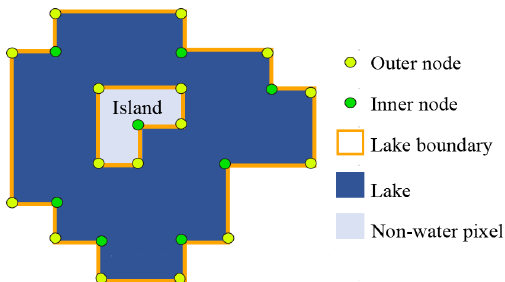
Figure A4. Sketch of outer and inner nodes for a glacial lake with an